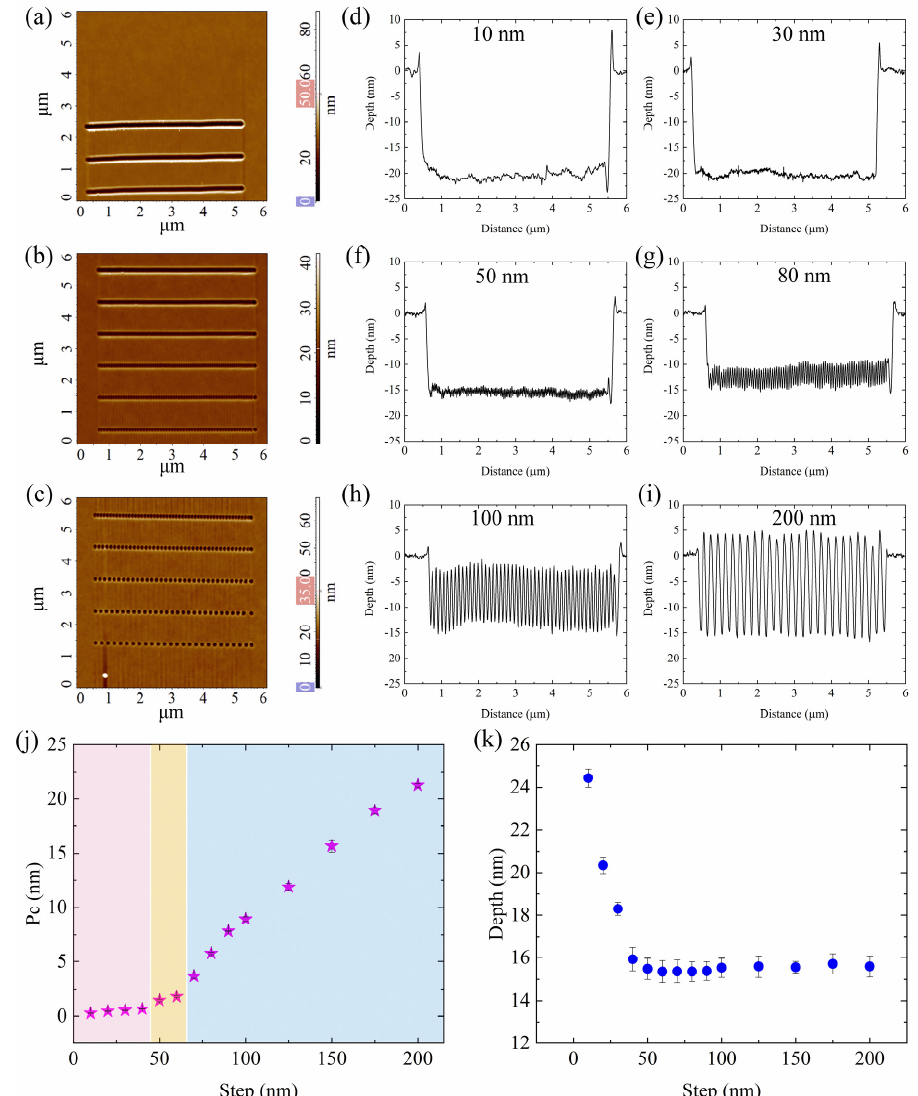
Figure 3. ( a – c ) SensHeight AFM images of nanogrooves sculpted with an increasing step values from 10 to 200 nm. The pink and blue boxes on the z-scalebar in ( a – c ) represent the minimum and maximum adjustment of the colour scale. ( d – i ) cross-sections of nanochannels sculpted with a step of 10, 30, 50, 80, 100, and 200 nm, respectively; ( j ) mean P c and ( k ) depth values, obtained by averaging 3 and 25 measurements, respectively, and plotted as a function of the step. The data reported in ( j ) and ( k ) are statistically significant for p < 0.01. From Figure 3a–c, it appears that as the step increases, the effect of overlapping between adjacent indentations is diminished more and more, and continuous structures